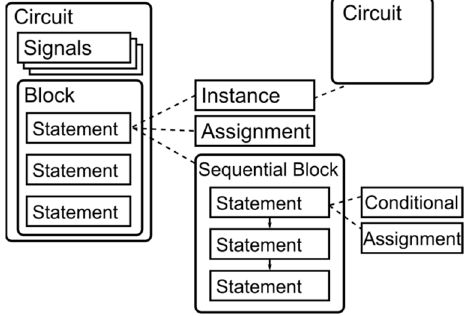
Figure 1. Components of a circuit model in a hardware description language.